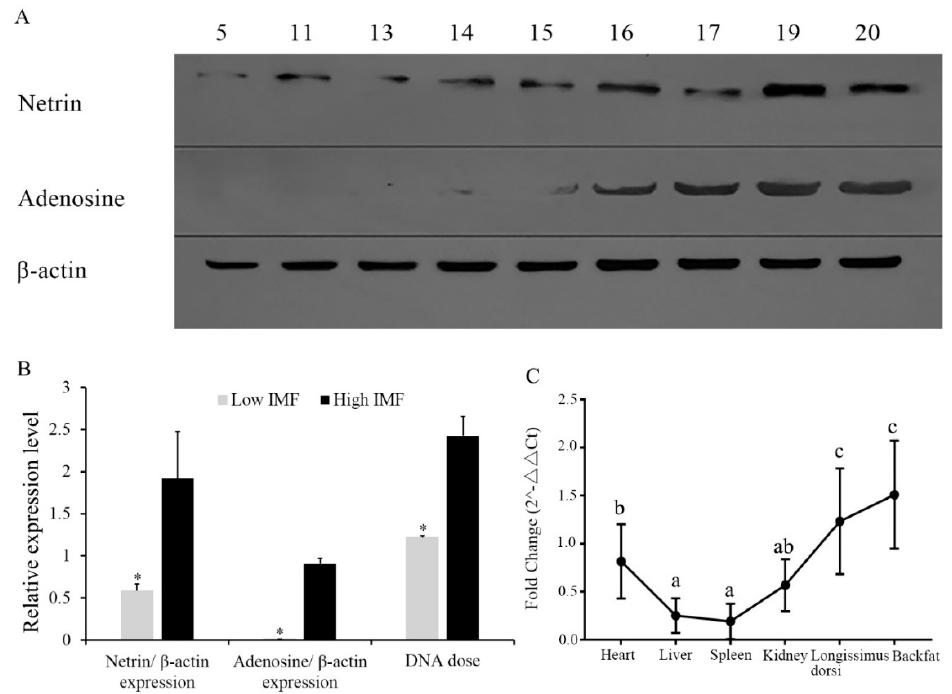
Figure 1. DNA, RNA, and protein expression of NTN1. ( A ) Protein expression of netrin and adenosine (n = 9, individual 5, 11, 13, 14 and 15 were low Intramuscular Fat (IMF), and individuals 16, 17, 19 and 20 were high IMF.). ( B ) Di ff erences of NTN1 and adenosine protein expression and NTN1 gene dose in high and low IMF pig longissimus dorsi. ( C ) Expression of NTN1 gene in di ff erent tissues. * p <